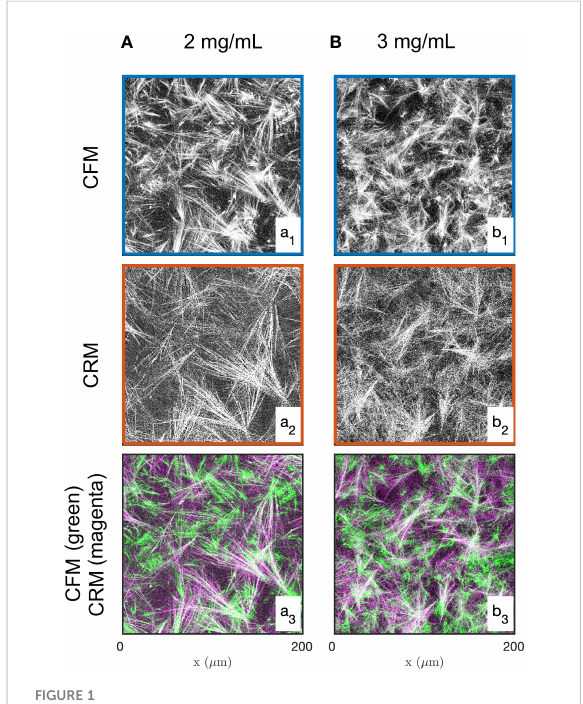
FIGURE 1 Images of the 2 mg/mL (A) and 3 mg/mL (B) acellular gels obtained by CFM (a1, b1) and CRM (a2, b2) . The bottom row (a3, b3) displays fused images with fl uorescence and re fl ectance data in green and magenta,